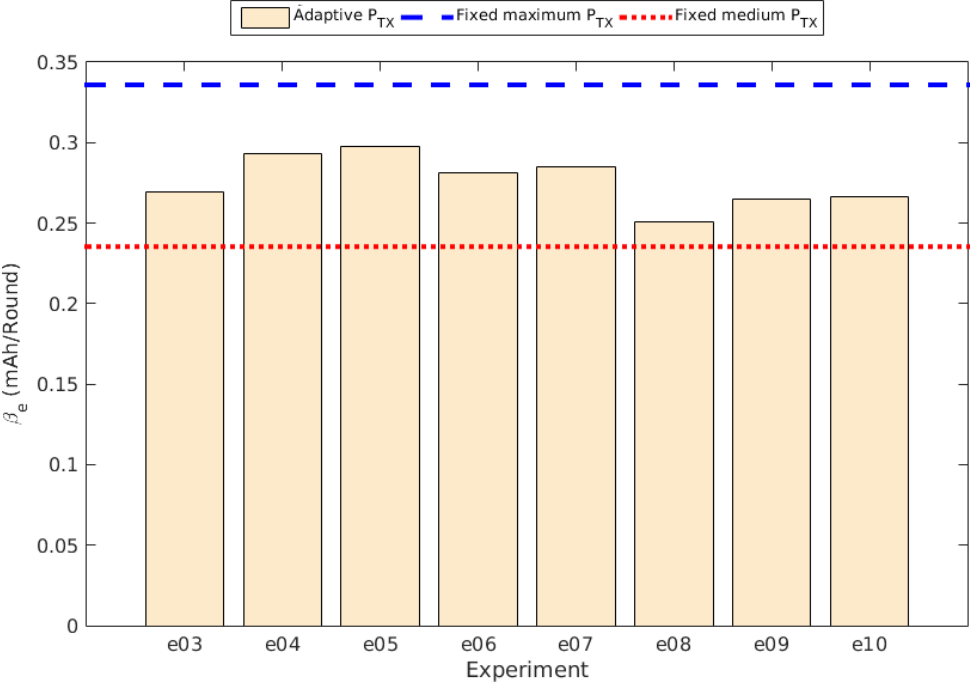
Figure 8. Slope ( β